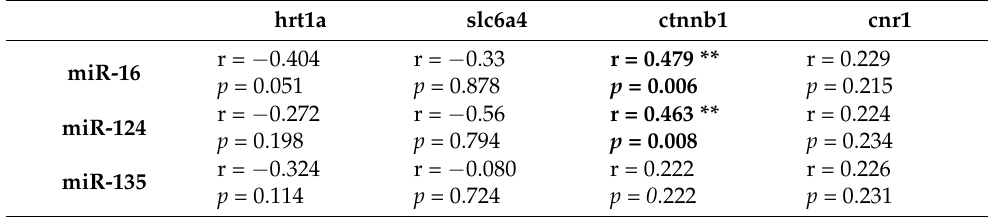
Table 3. Pearson correlation coefficients between miRNA levels and genes in the NAc in rats exposed to UCMS and CBD.